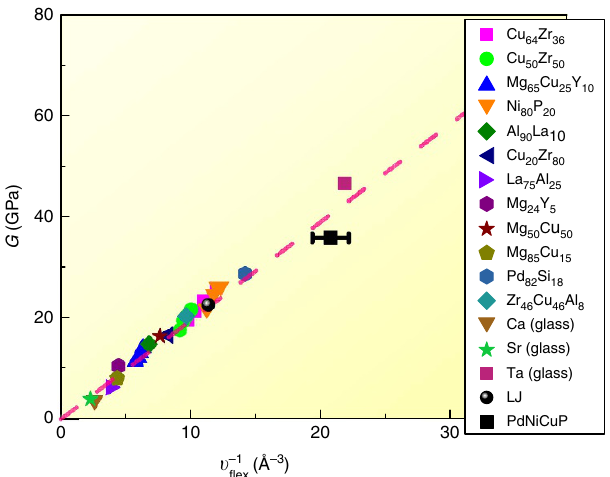
Figure 2 | Correlation between shear modulus and flexibility volume in metallic glasses. The values of G and u flex are computed for 32 MGs at 300K (see Supplementary Table 1 for different cooling rates and compositions, including an L-J glass). The dashed straight line is the predicted correlation derived in equation (2). The data point for the Pd-Ni- Cu-P MG is from an experimental measurement of both G and u flex (from MSD) for a given sample 50 (see discussion in Supplementary Note